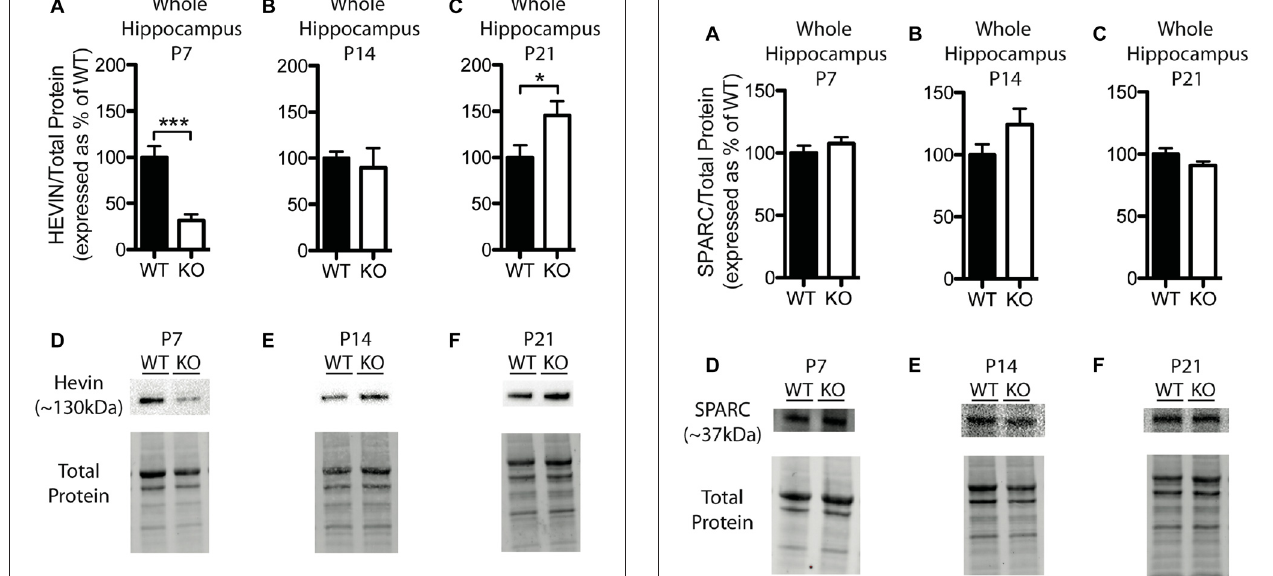
FIGURE 5 | SPARC expression is not significantly altered in the hippocampus of Fmr1 KO mice. (A–C) SPARC expression, determined via Western blotting, in the hippocampus of WT (black, n = 8) and Fmr1 KO (white, n = 8) mice at postnatal day (P) 7, P14 and P21, respectively. Bands representing SPARC were normalized against the total protein within the same lane on the membrane, and were then expressed as a percent of the average level of SPARC in the WT group. (D–F) Representative western blots with bands at ∼ 37 kDa corresponding to SPARC in hippocampal samples (30 µ g of protein per lane) from WT and Fmr1 KO mice at P7, P14 and P21, as well as the total protein within each